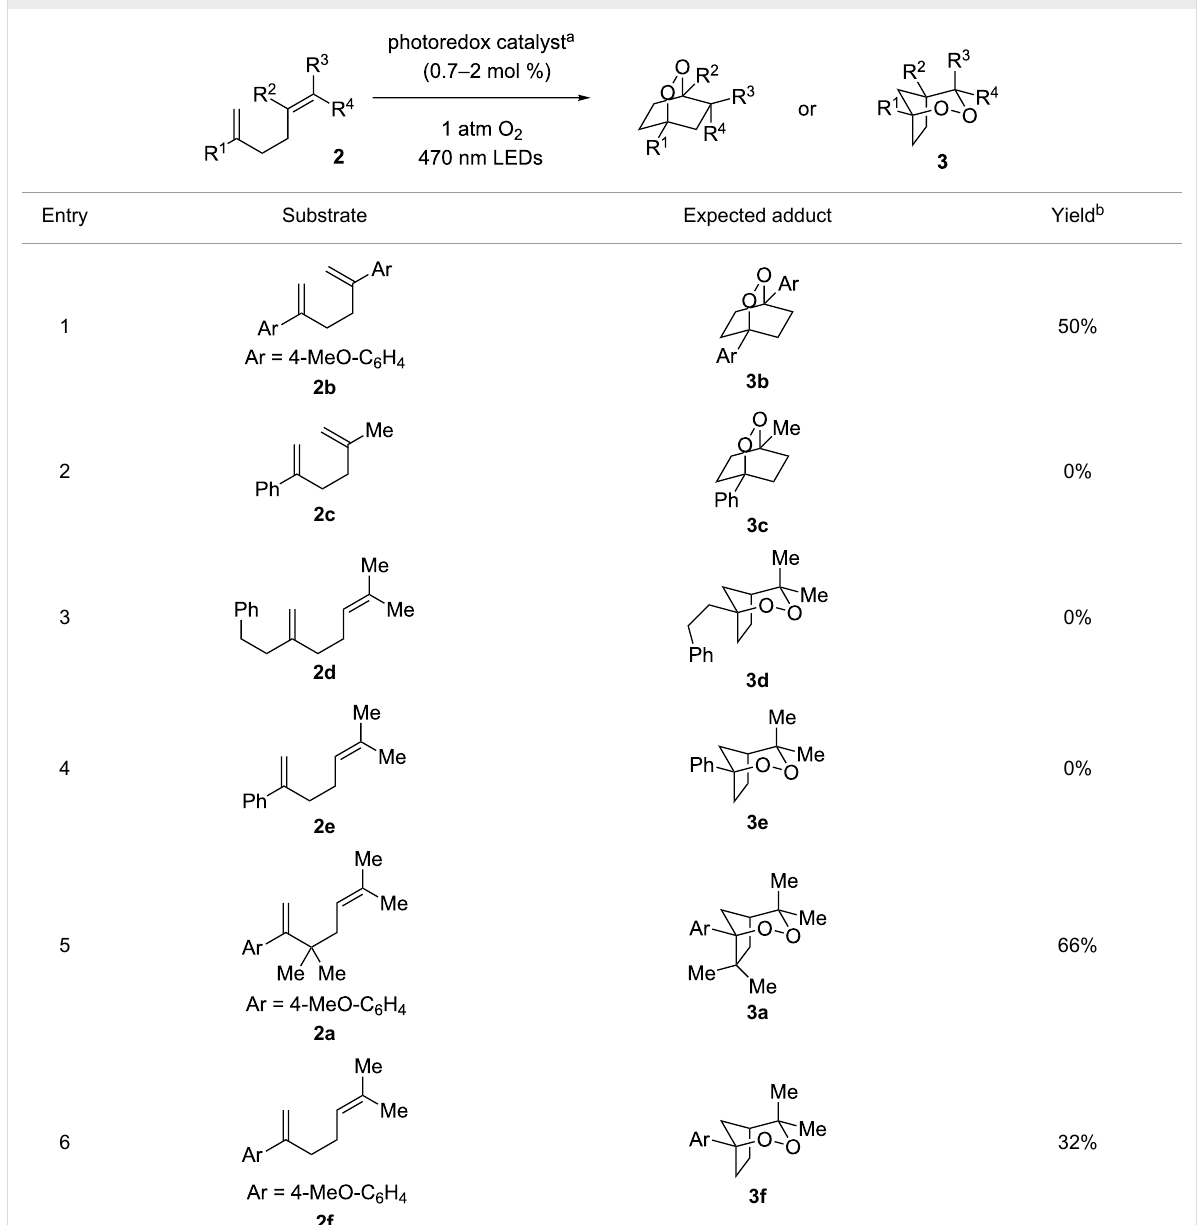
Table 2: Diene structure investigation for endoperoxidation